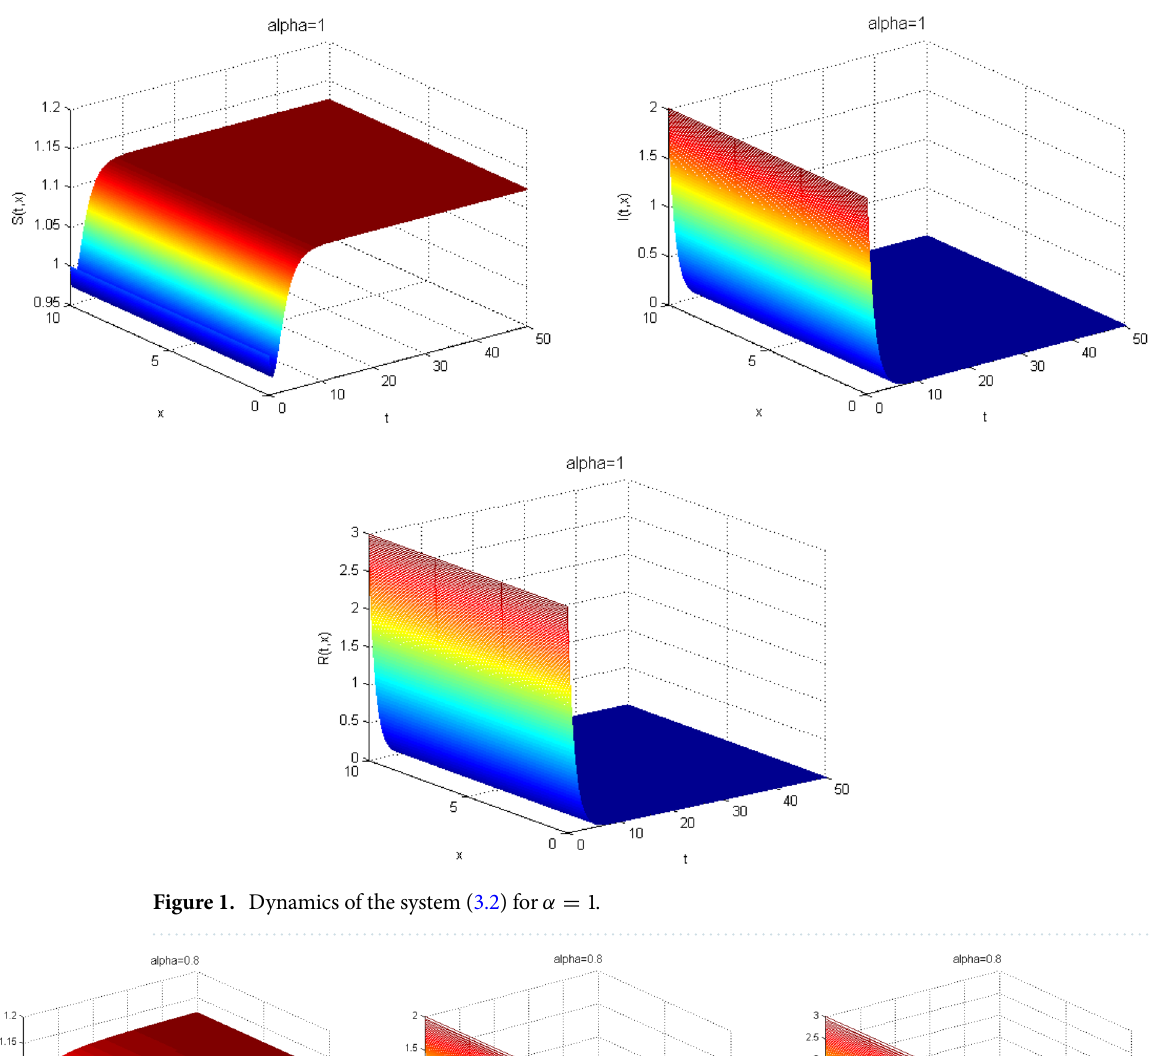
Figure 1. Dynamics of the system (3.2) for α = 1 .